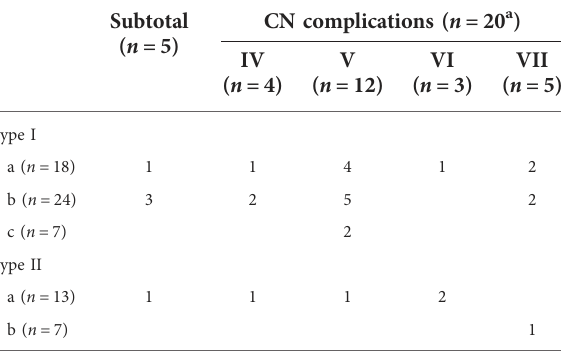
a As some patients had injury to multiple cranial nerves after operation, the sum of the cranial nerve cases ( n =24) is larger than the total number of the complication cases ( n